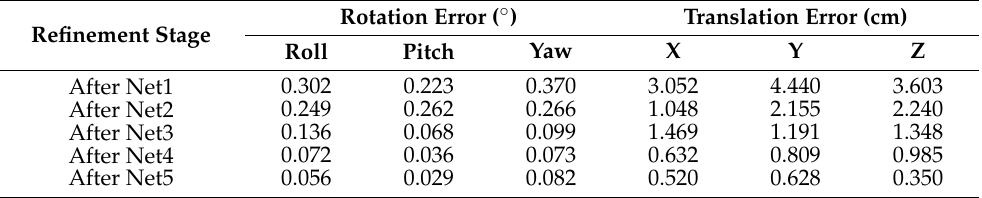
Table 3. Quantitative results of calibration performed on the Oxford dataset without temporal filtering.